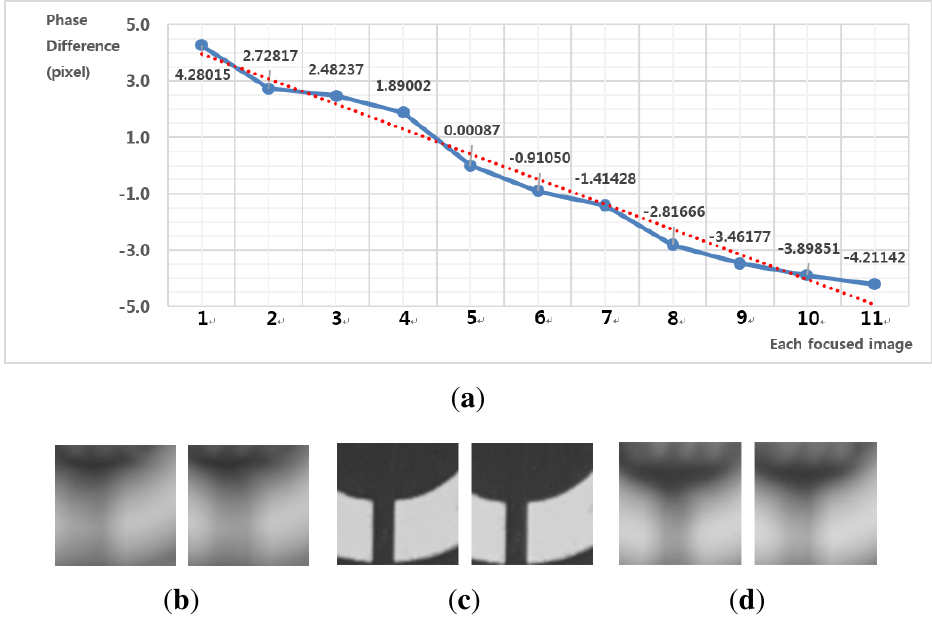
Figure 11. The results of motion estimation for different phases: ( a ) estimated motion vectors versus the phase difference; ( b ) pair of left- and right-phase images at the front-focus position (Image 1) with a phase difference of 4.28015; ( c ) at the in-focus position (Image 5) with a phase difference of − 0.91050; and ( d ) at the far-focus position (Image 11) with a phase difference of − 4.21142.